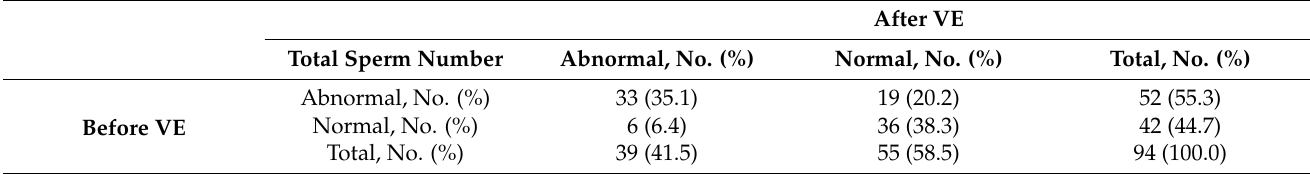
Table 3. Cross-tabulation table showing the number of patients with abnormal and normal total sperm number (TSN) on the first semen analysis before varicocele embolization (VE) versus those on the second semen analysis after VE.